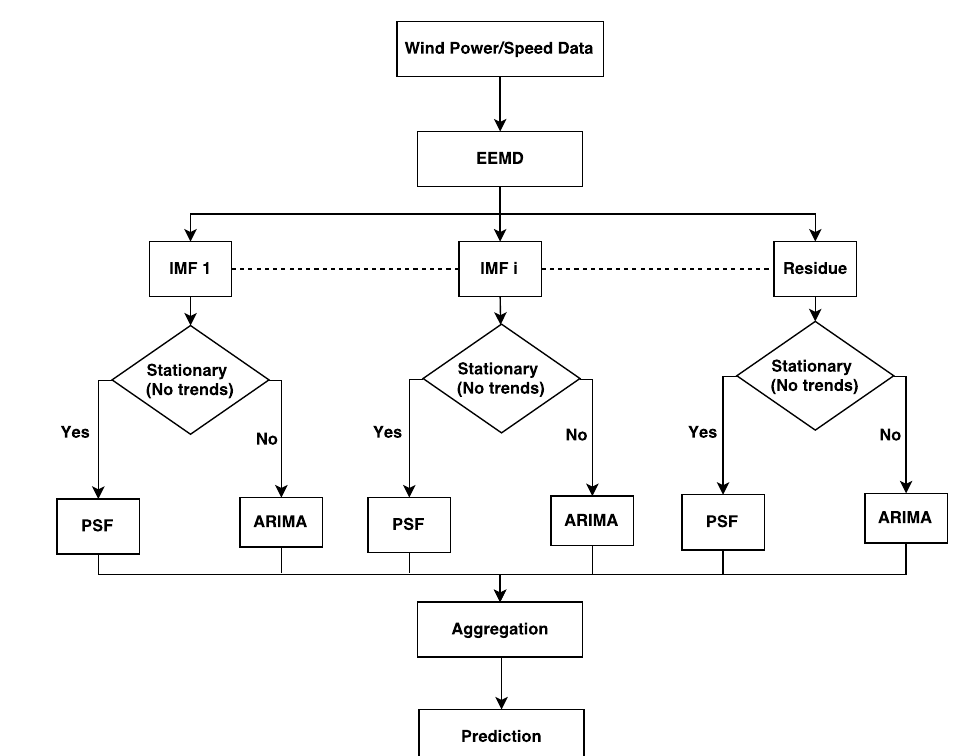
Figure 3. The procedure of EEMD-PSF-ARIMA